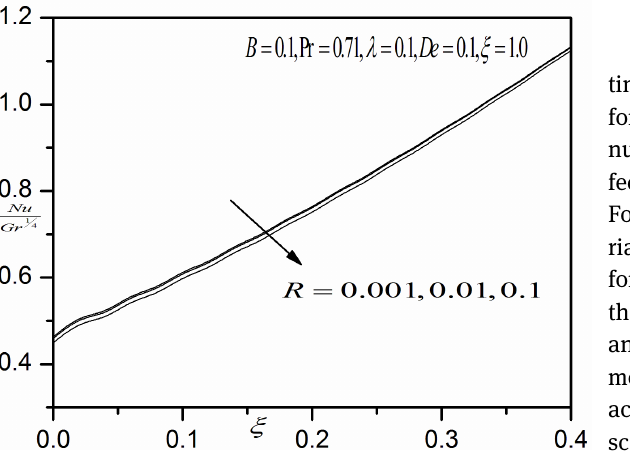
Fig. 19: Influence of Pr on the Nusselt number